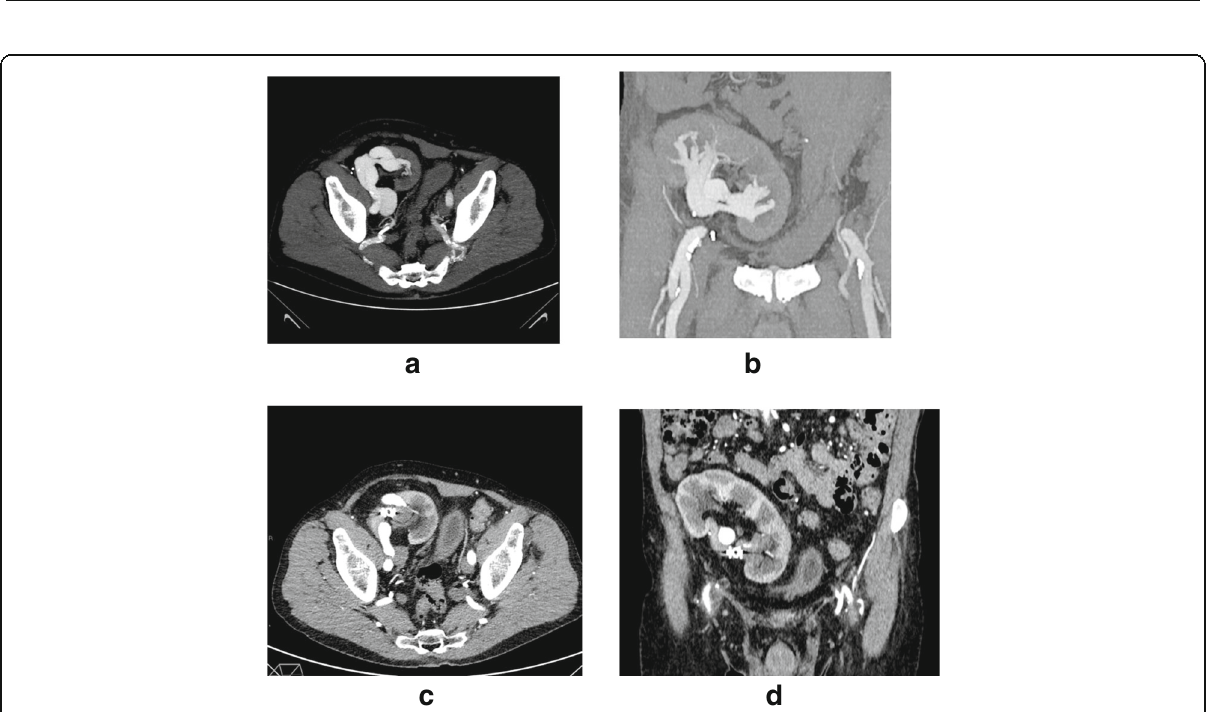
Fig. 5 2-month follow up CT angiogram. Pre procedure axial ( a ) and coronal ( b ) and post procedure axial ( c ) and coronal ( d ) images prove successful closure of AVF with Amplazter plug and no perfusion